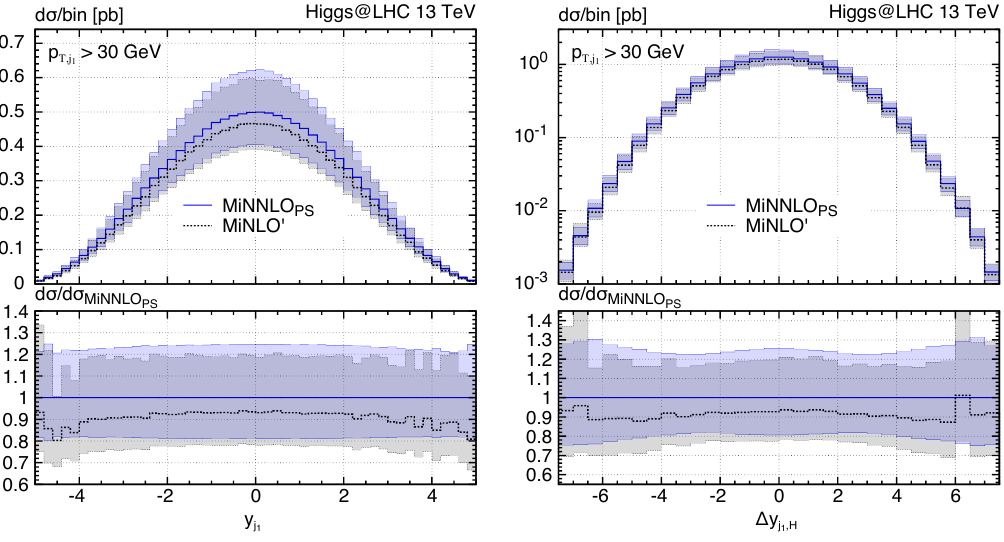
Figure 3 . Distribution in the rapidity of the leading-jet (left) and its rapidity di(cid:11)erence with the Higgs boson (right) for MiNNLO PS (blue, solid) and MiNLO 0 (black,